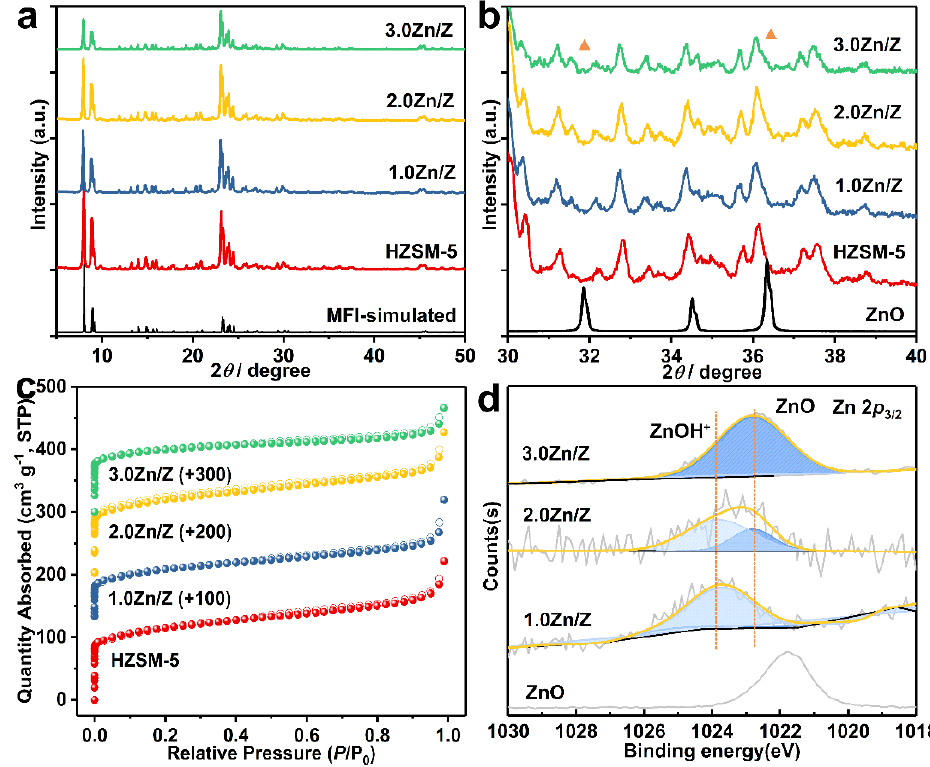
Figure 1. X − ray diffraction (XRD) patterns in the range of 5–50 ◦ of ZSM-5 samples and MFI simulated one ( a ), and in range of 30–40 ◦ of ZSM-5 samples and ZnO ( b ); N 2 adsorption-desorption isotherms at 77 K of HZSM-5 and Zn-modified ZSM-5 zeolites ( c ); fittings of Zn 2 p 3/2 peaks in X − ray photoelectron spectroscopy (XPS) spectra of ZnO and Zn-modified ZSM-5 samples ( d